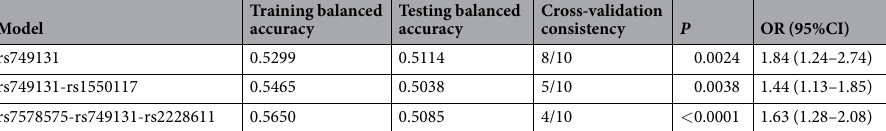
Table 6. MDR analysis results of the interaction between the four